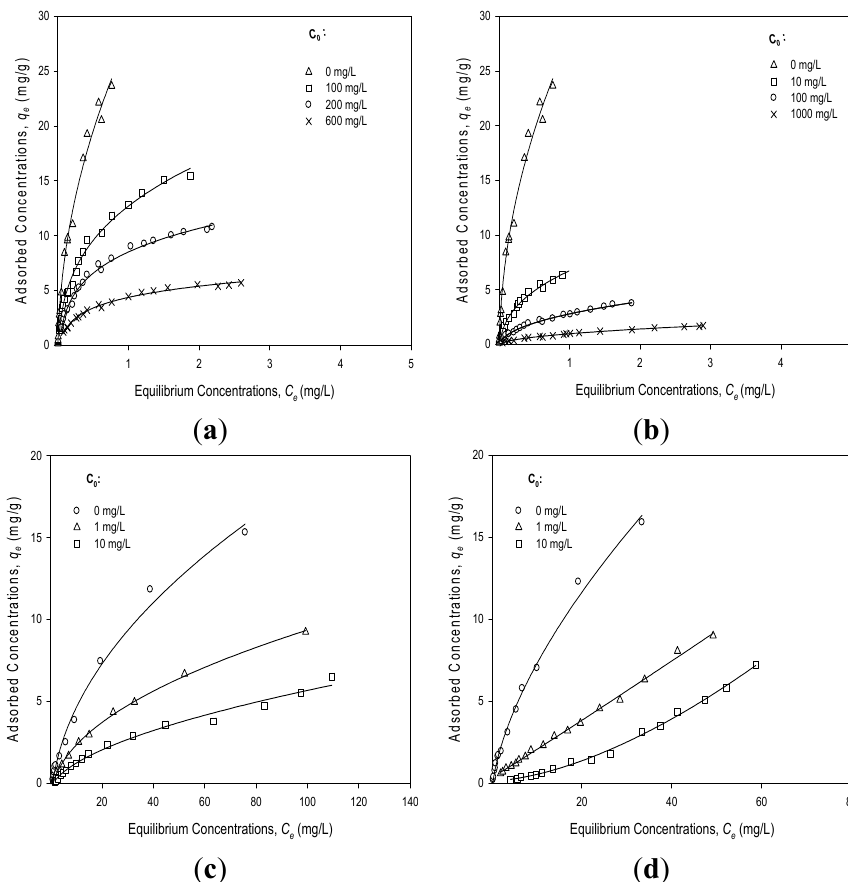
Figure 3. Single-solute and bi-solute isotherms of PHEN and DCP and NBZ on HBPMS and the fitting of the FM model: ( a ) PHEN isotherms with or without NBZ (at pH 7.0) as the competitor. ( b ) PHEN isotherms with or without DCP (at pH 7.0) as the competitor. ( c ) DCP isotherms with or without PHEN (at pH 7.0) as the competitor. ( d ) NBZ isotherms with or without PHEN (at pH 7.0) as the competitor. C 0 (mg/L) is the added dose of the competitors.